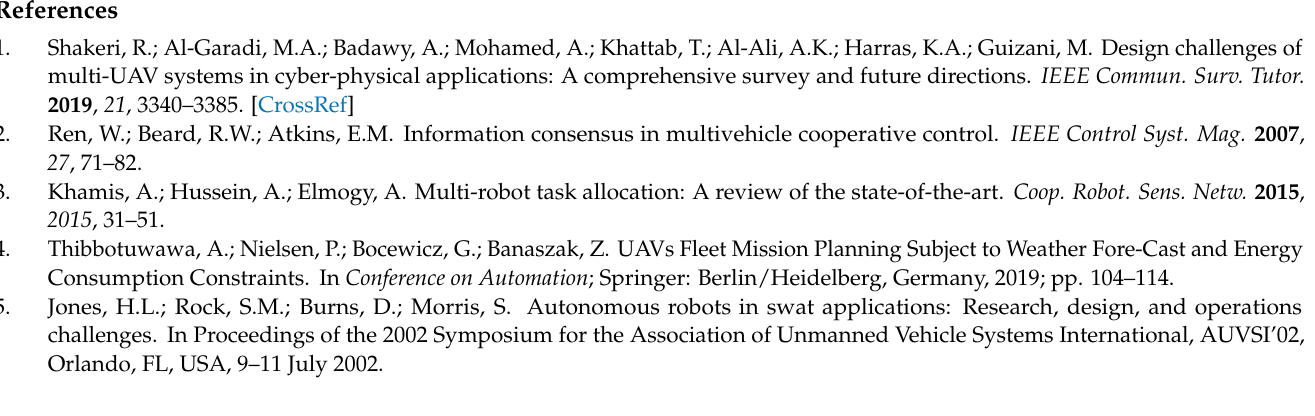
the red target during the movement. The R 2 agent is closer to the yellow target and easier to run around the obstacle than the R 1 agent. Therefore, it is assigned to the yellow target after removing the red target. Another example can be seen from Figure 6b. The R 2 agent changes its position from the back to the left to avoid the possibility of collision to the obstacle. The same can be found in the red group of Figure